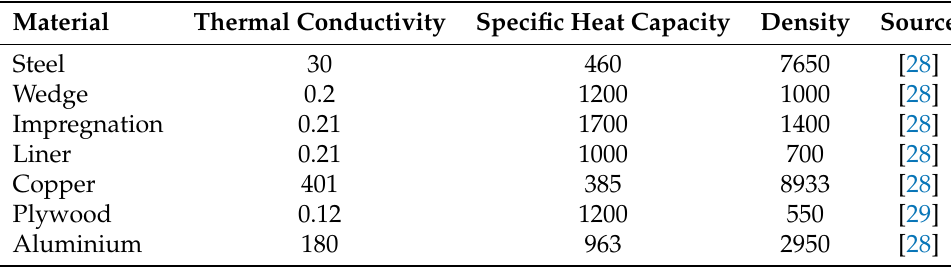
Table 1. Thermal conductivity and specific heat capacity of typical